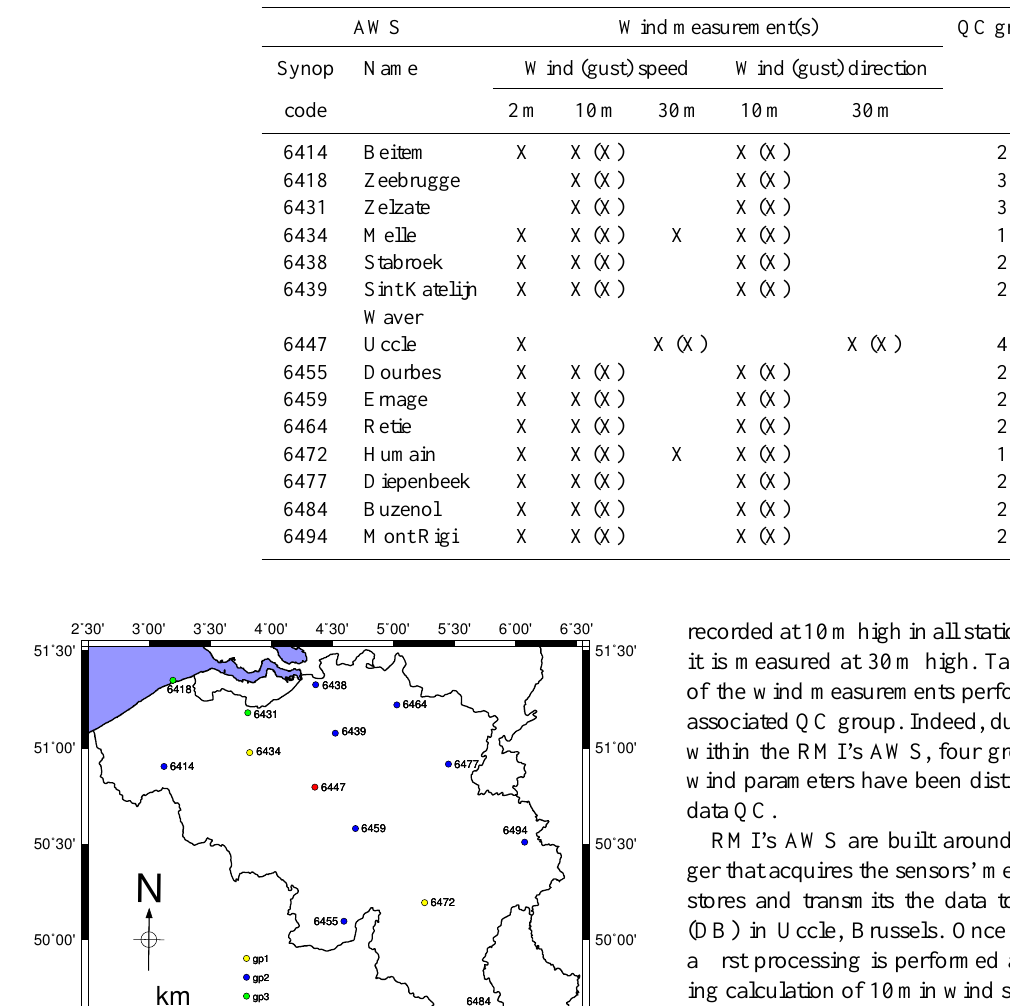
Table 1. List of the 14 RMI’s Automatic Weather Stations performing wind observations and the associated measurements. Group of stations with similar measurements are defined by “QC group”.